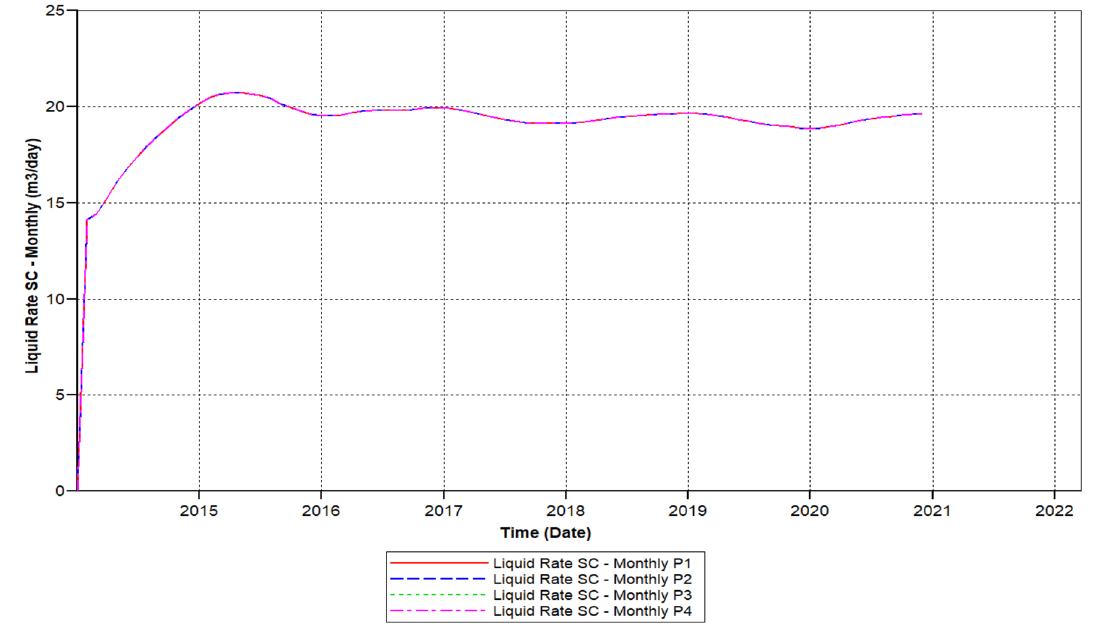
Figure 15. Shows the liquid ratio afterwards the cross-linked gel treatment graph CMG STARS 2017.10 URL: https:// www. cmgl. ca/.